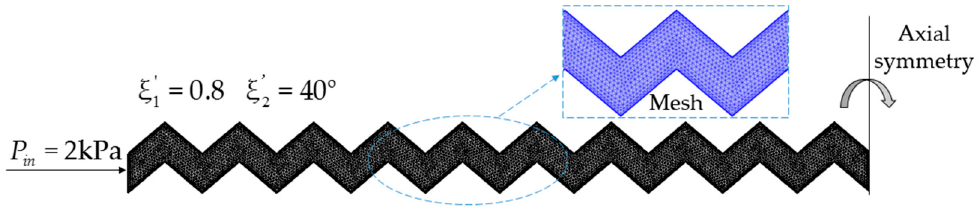
Figure 26. Numerical model of the grouting diffusion process in isotropic rough fractures.